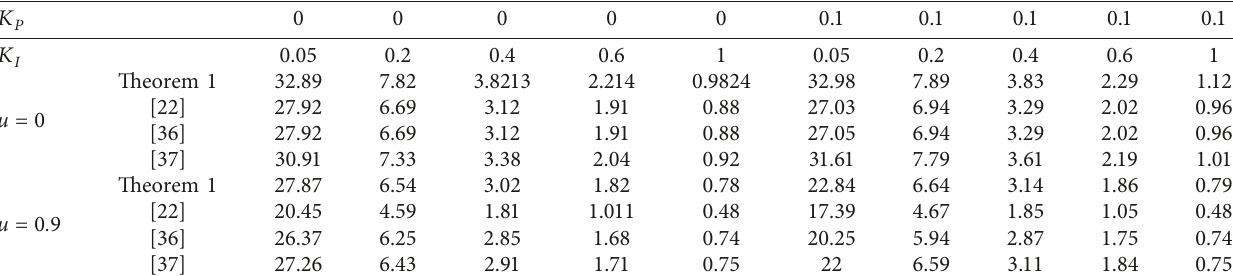
Table 5: Delay margin h ∝ ( K